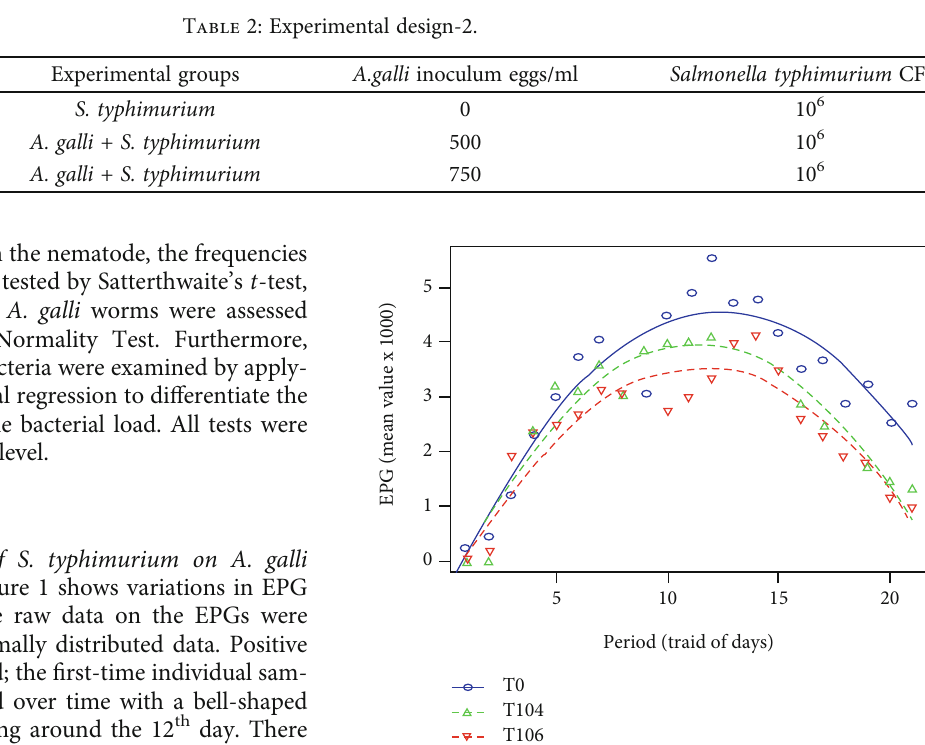
: concentration 500 0